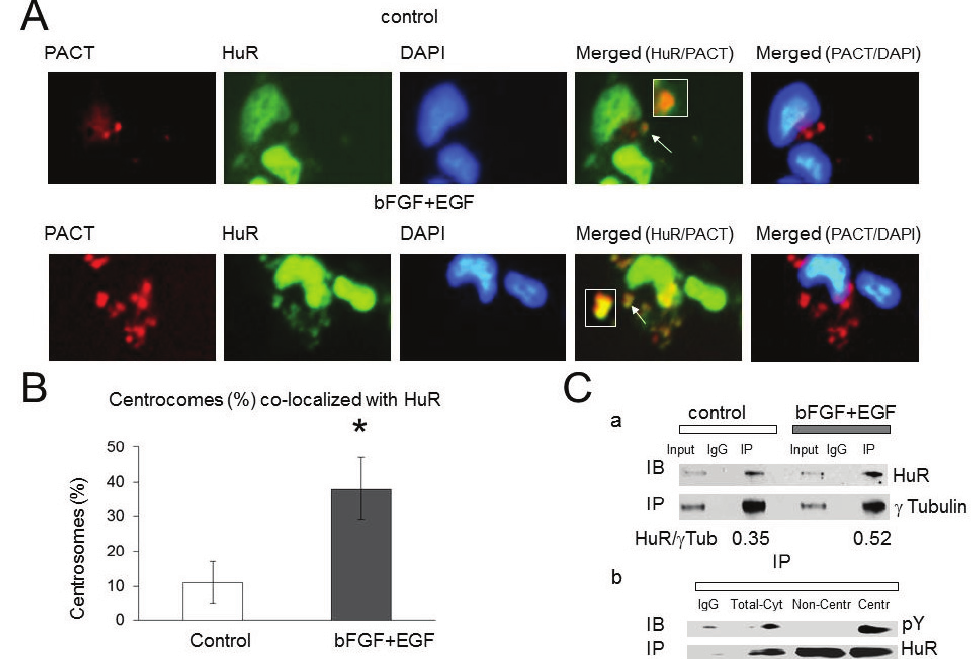
Figure 3. HuR association with the pericentriolar matrix (PCM) is enhanced by growth factors. ( A ) Examples of HuR-EGFP co-localization with centrosomes marked with the PACT domain of pericentrin attached to the red fluorescence protein (PACT-mKO1) in control and growth factor stimulated conditions. Nuclei were stained with DAPI. ( B ) The graph represents the averaged percentages of centrosomes co-localized with HuR-EGFP in control (11 ± 6, n = 4) and growth factor stimulated conditions (38 ± 9, n = 4). The difference is significant, p = 0.01; ( C ) (a) Illustration of HuR co-immunoprecipitation with (cid:2)-tubulin from cells non-stimulated and stimulated with growth factors. The IgG line illustrates the results of co-immunoprecipitation performed with rabbit IgG antibody as control. ( C ) (b) Illustration of HuR phosphorylation at tyrosine residues detected with pY antibody after HuR immunoprecipitation from cytoplasmic lysate (line Total-Cyt), non-centrosome fraction (line Non-Centr), and crude centrosome fraction (line Centr). Note the accumulation of pY-HuR protein in the crude centrosome